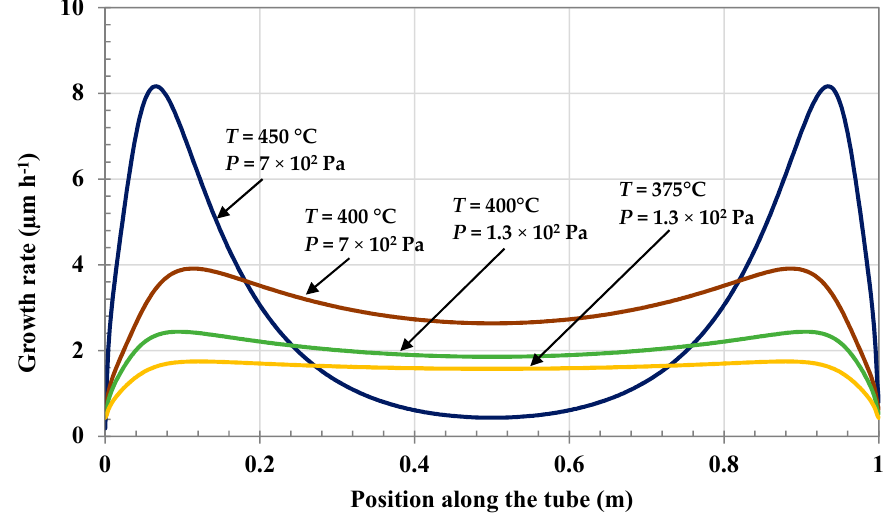
Figure 8. Calculated growth rate of chromium carbide along the 1 m reactor walls with alternate injection ( T = 450, 400 and 375 °C).